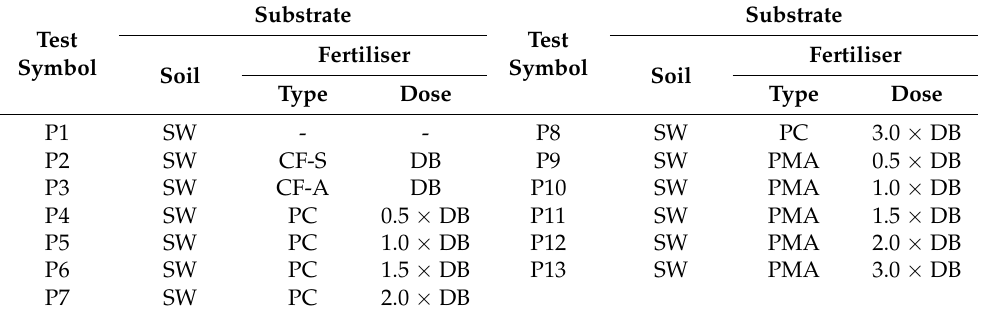
Table 12. Substrate preparation for pot